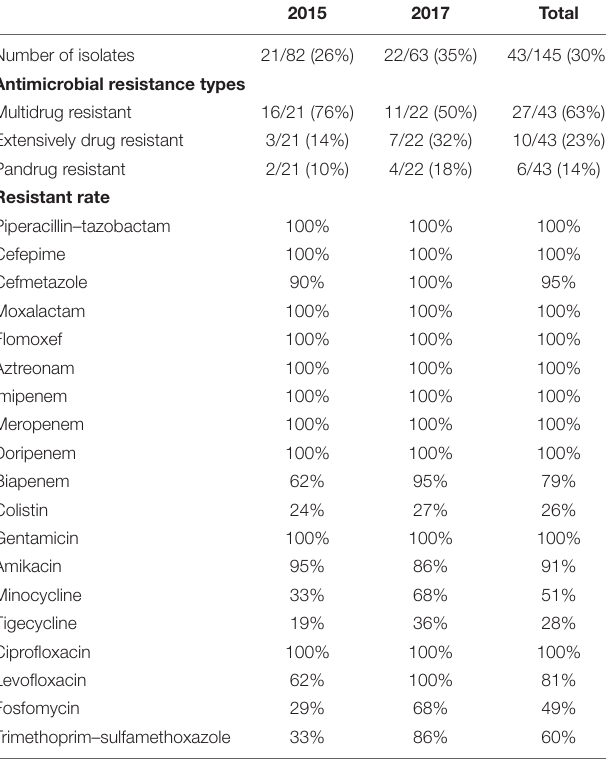
TABLE 1 | Susceptibility of carbapenemase-producing Klebsiella pneumoniae in